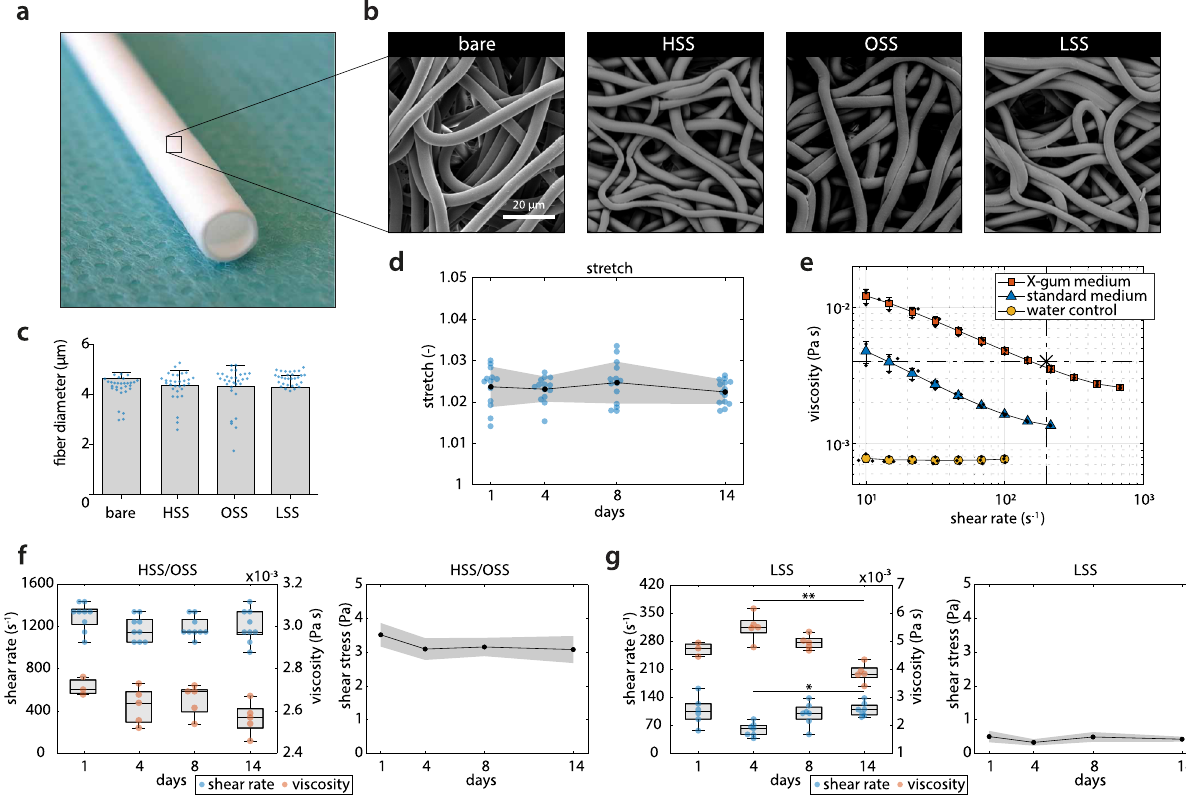
Fig. 3 In vitro modeling of scaffold-guided vascular growth. a Electrospun PCL-BU vascular scaffold prior to culture ( ϕ 3 mm). b Scanning electron microscopy images of dynamically cultured samples after decellularization for each experimental condition, and of an 8-day statically cultured cell-free sample (bare). c Quanti fi cation of scaffold fi ber diameter at the outside of the (decellularized) constructs ( n = 30 fi bers/condition). d Temporal variations in cyclic stretch for all loading conditions ( n = 13 or 14/day). e Shear rate dependent viscosity in X-gum-enriched medium (red squares, n = 3), standard medium (blue triangles, n = 3), and water (yellow circles, n = 3). The * indicates blood viscosity at 200 s − 1 . f , g Temporal variations in shear rate (left axis, n = 6, 7, or 9/day), viscosity (right axis, n = 3 or 5/day), and shear stress (right, derived from the actual (measured) medium viscosity) in the high, oscillating, and low shear stress conditions. Bars and black dots represent mean, error bars and gray area indicate standard deviation, boxplots contain 50% of the data with median highlighted by central mark (* p < 0.05, ** p <